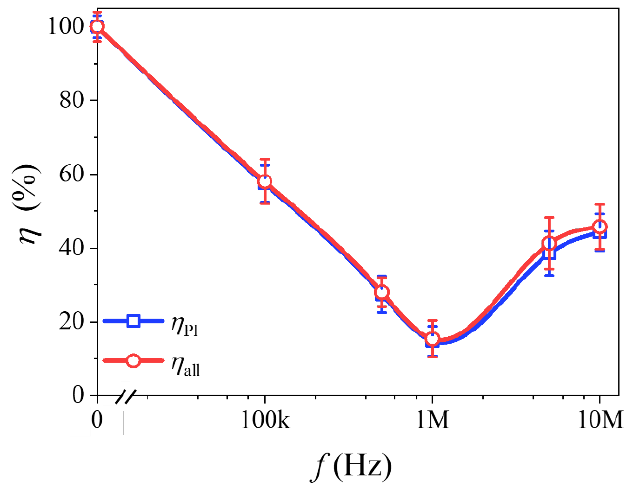
Figure 4. The crystallization ratio of pure ice 𝜂 PI and all ice crystals 𝜂 all .